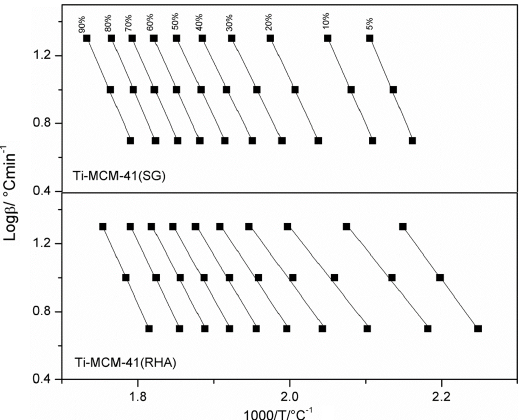
Figure 3. Logarithmic of the heating rate as a function of the inverse of temperature of the Ti-MCM-41 (a) (SG) and (b) (RHA) (β of 5, 10, 20 °C min –1 ).